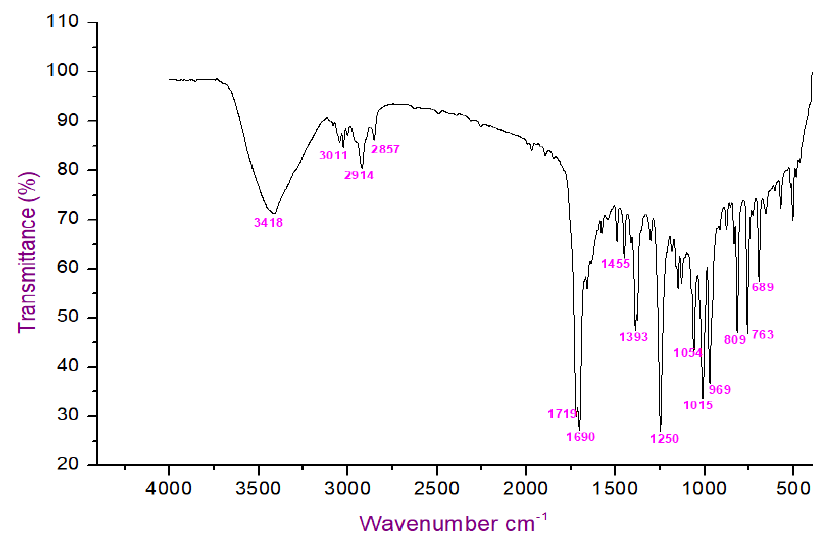
Figure 2. FTIR analysis of isolated compound.